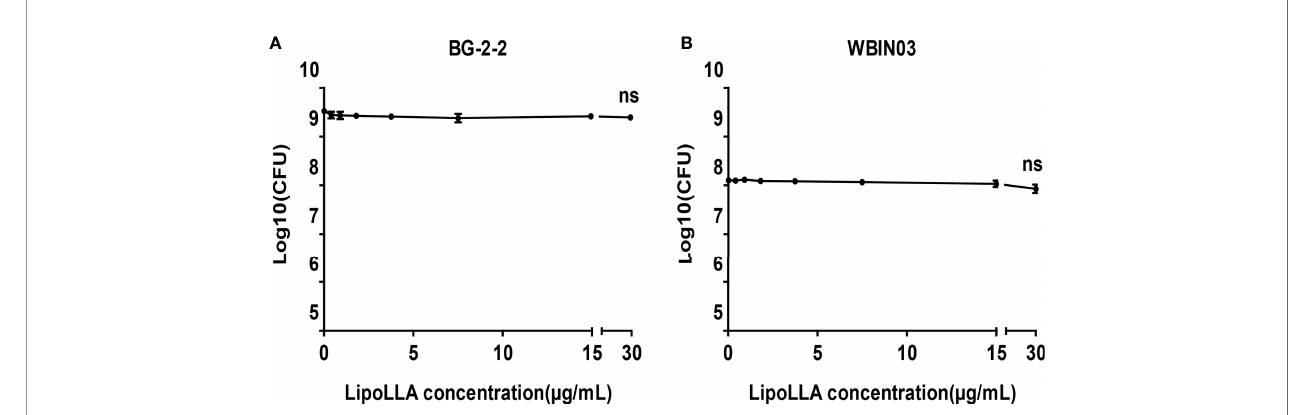
FIGURE 5 | Bactericidal effect of LipoLLA on probiotics. Antibacterial activity of LipoLLA against Lactobacillus BG-2-2 (A) and Bi fi dobacterium WBIN03 (B) . ns, P > 0.05, The viable count after LipoLLA treatment was not signi fi cantly different from that in the control